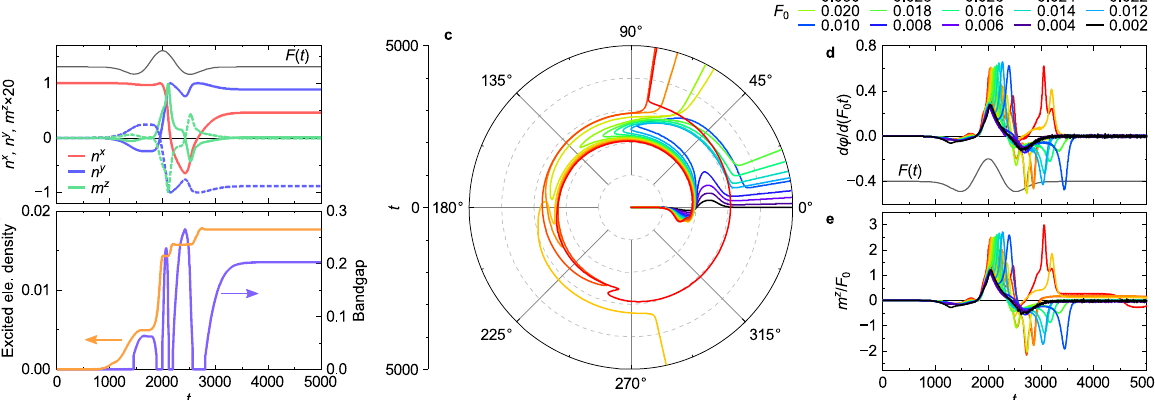
Fig. 3 Real-time dynamics induced by the monocycle pulse. a , b The time evolution of a the Néel vector and uniform magnetization, and b excited electron density and energy bandgap, as functions of time t , for F 0 ¼ F 0 ð cos π = 4 ; sin π = 4 ; 0 Þ and F 0 = 0.02. The dashed lines in ( a ) denote the results for the ½ 110 (cid:4) polarization. c Polar plots of the in-plane angle of the Néel vector with respect to time t for F 0 = 0.002 – 0.03. d , e The time derivative of the in-plane Néel vector angle and the z component of the uniform magnetization divided by F 0 for F 0 = 0.002 – nonequilibrium staggered spin density of the itinerant electrons through the spin-orbit coupling, and it generates torques in the [001] direction (see Fig. 2d). Then, the two sublattice magnetic moments are slightly canted towards the [001] direction, which means m z > 0. The easy-plane anisotropy, whose energy per